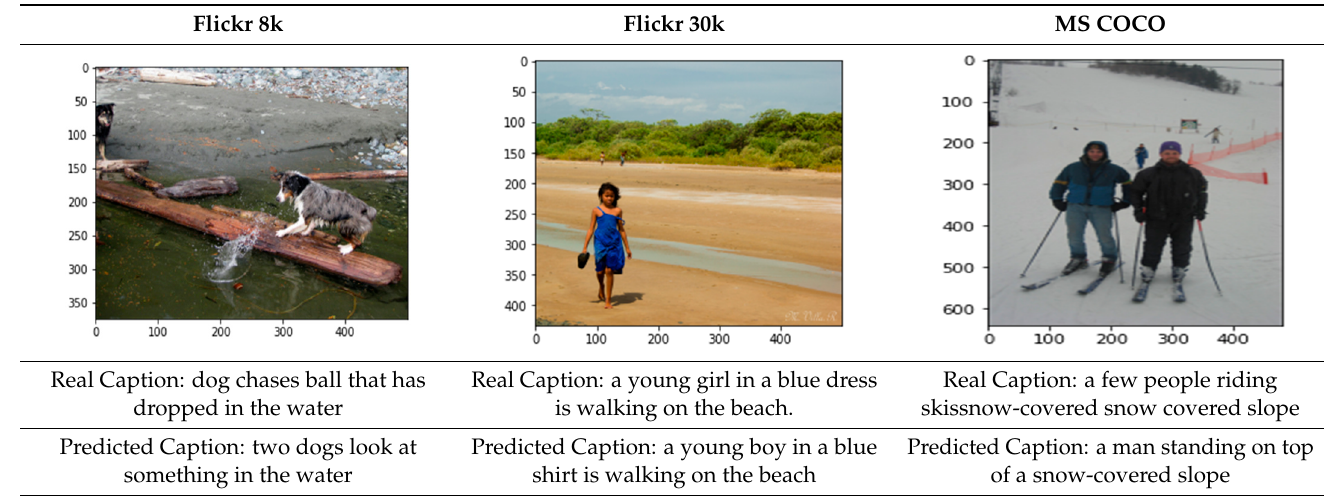
Table 5. A comparison of captions generated using the encoder–decoder model on Flickr 8k, Flickr 30k, and Microsoft Common Objects in Context (MS COCO) datasets.